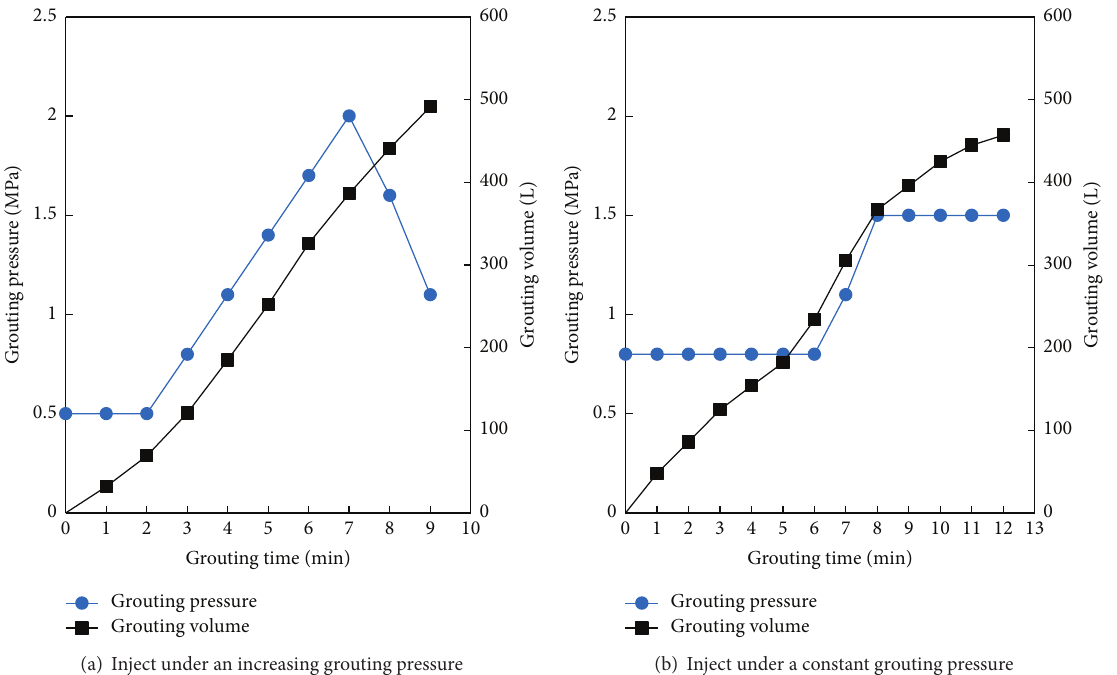
Figure 13: The typical grouting process of